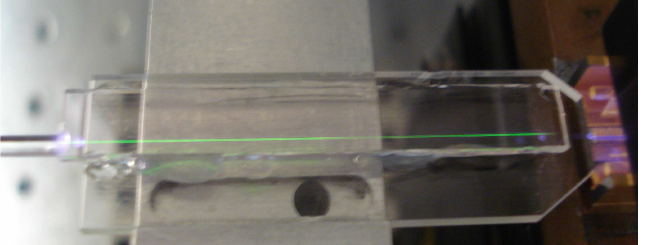
Figure 11. Photo of the green light propagating in the single mode ( upper ) waveguide in the structure of Figure 11. Pump wavelength is around 980 nm, and the green color, due to upconversion emission from excited Er + ions, proves that the transfer from the pump to the active layer is effective.